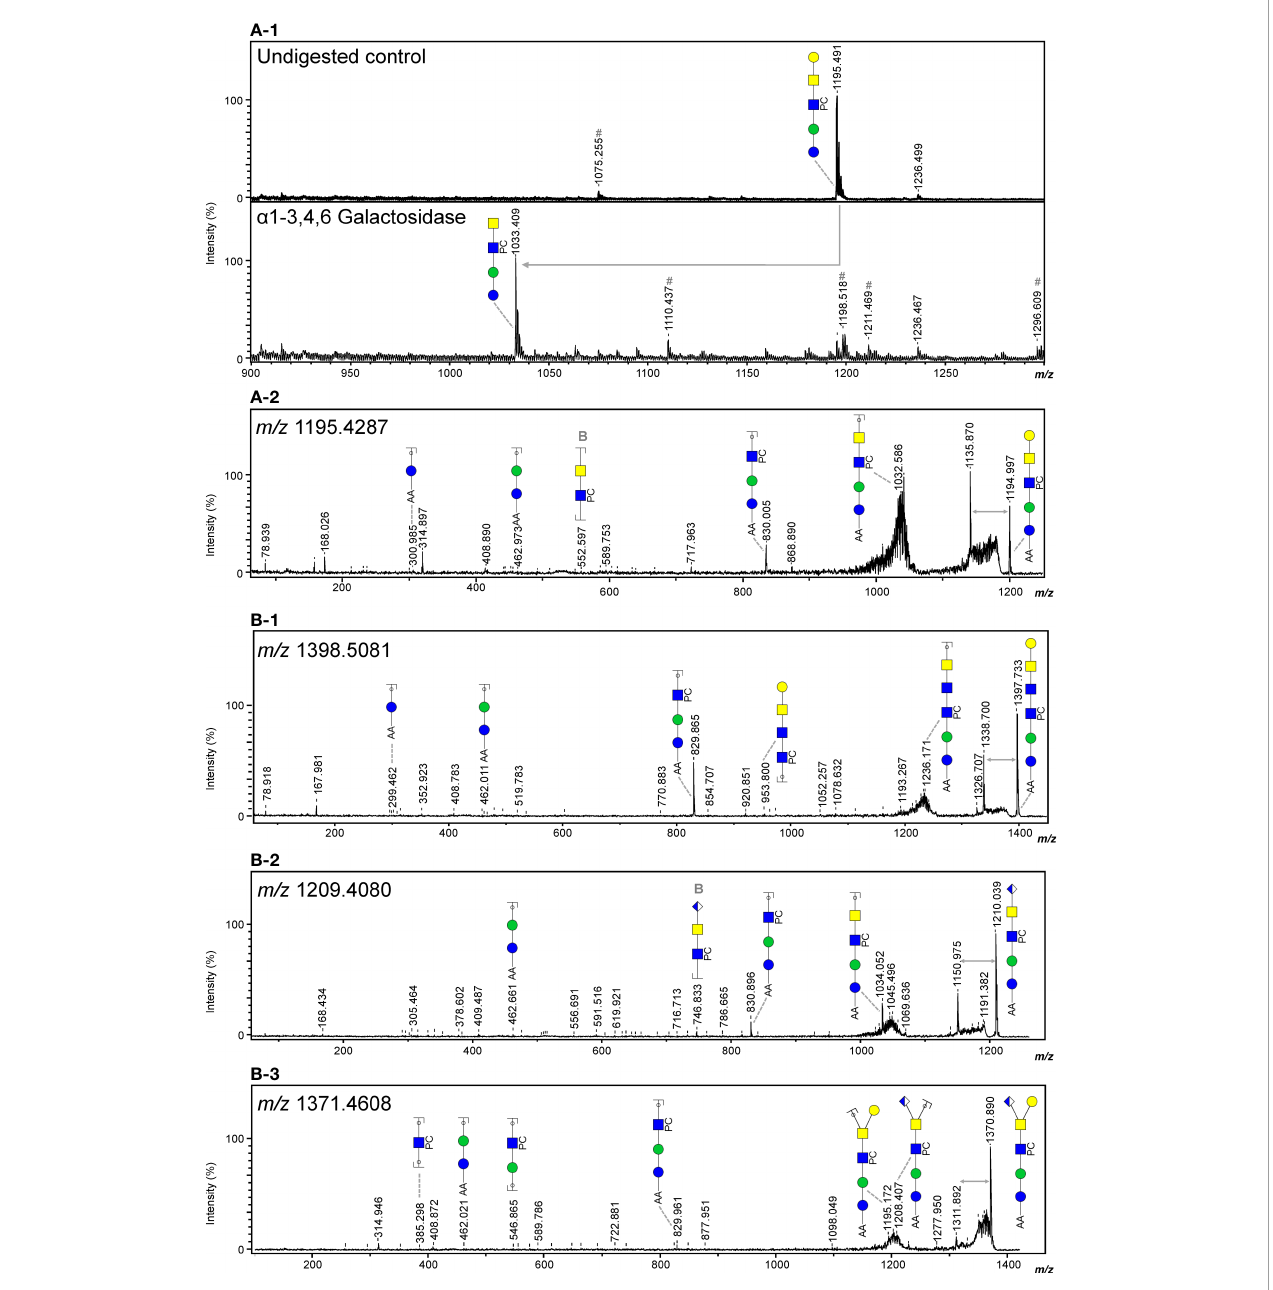
FIGURE 4 Evidence of terminal a -Gal and GlcA-containing epitopes in the GSL glycans of O. volvulus . MALDI-TOF-MS analysis of 2-AA-labeled O. volvulus major GSL glycan species subjected to digestion with a 1-3,4,6 galactosidase (A-1) Digestion product showing the loss of a terminal a -Gal ( D m/z = 162) is highlighted using a grey arrow. Negative ion re fl ectron mode MALDI-TOF-MS/MS of ions with theoretical m/z 1195.4287 (A-2) , m/z 1398.5081 (B-1), m/z 1209.4080 (B-2) and m/z 1371.4608 (B-3). Resulting spectra are labeled with graphic representation of Y-type ions, unless indicated otherwise (B = B- type). Loss of mass 59 Da from the parent ion is indicative of a PC loss (44, 45) and is highlighted by grey double arrows. For both MALDI-TOF-MS/MS and MALDI-TOF-MS spectra monoisotopic masses of 2-AA-labeled glycans are indicated and glycans are represented using the CFG nomenclature (see symbol key insert in Figure